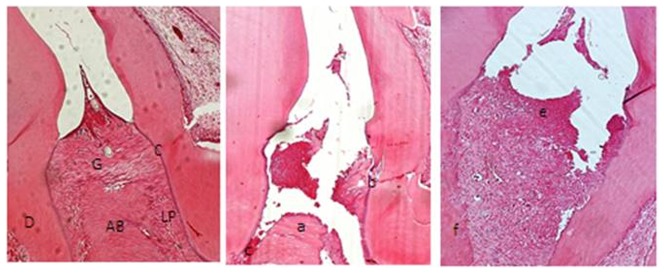
Microscopic analysis.(A) Normal periodontium and (B) periodontium from a rat presenting with periodontitis (treated with saline) showing alveolar bone and cementumresorption and inflammatory cell infiltration. (C) Reduced inflammation and alveolar bone loss in the periodontium of rats treated with Atorvastatin (10 mg/kg) for 10 days. Sections were stained with H&E. Microscopic original magnification at 40×. Scale bars = 100 µm. G = gingiva; PL = Periodontal ligament; D = dentin; AB = alveolar bone; C = Cementum; a = increased bone loss in AB; b = resorption of cementum; c = inflammatory process in PL and intense destruction of collagen fibers in the PL; e = decreased inflammation process in PL anddiscrete destruction ofcollagen fibers in PL; f = decreasedbone loss in AB.